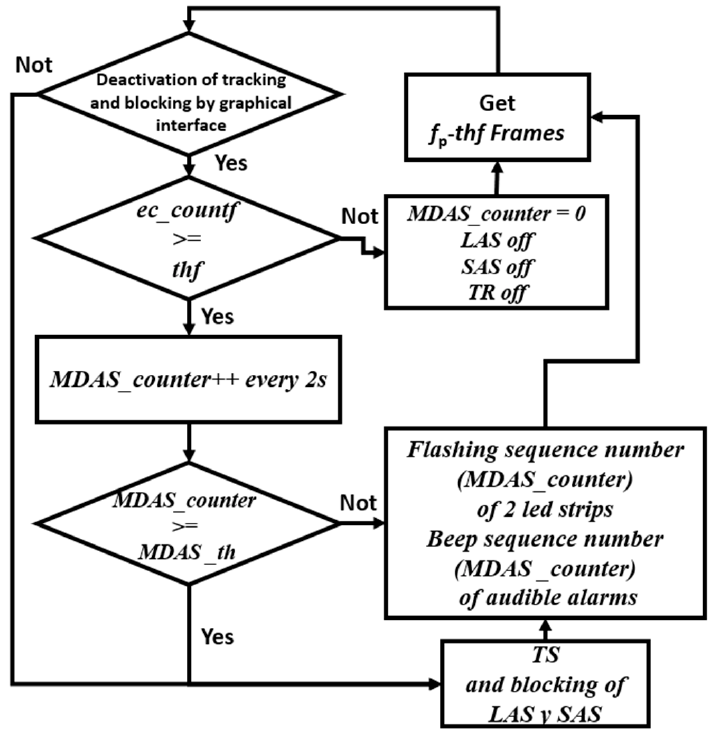
Figure 16. Activation and deactivation process of LAS, SAS, and TS in the driver’s distraction detection.